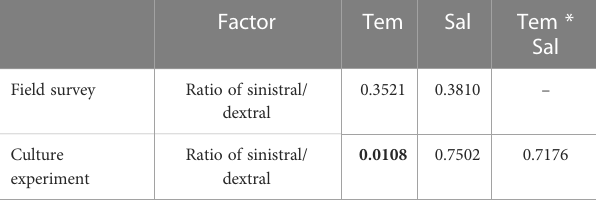
Table entries are p -values (marked in bold when p < 0.05) from two-way